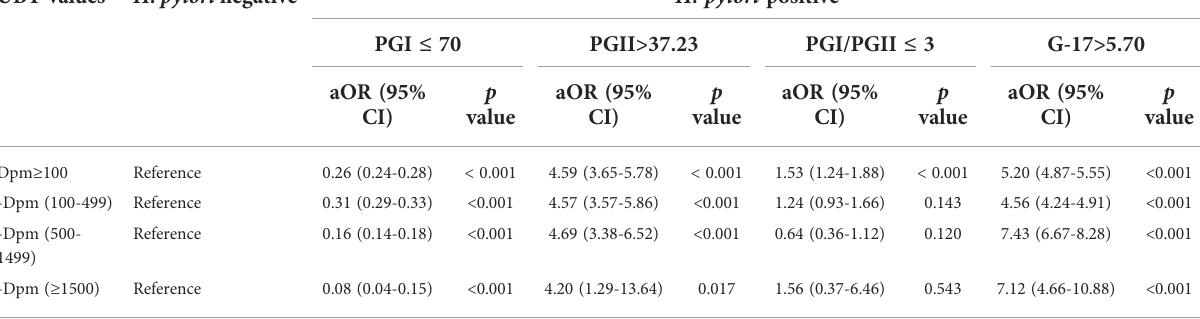
TABLE 2 Adjusted ORs for abnormalities of serum PGs and G-17 in H. pylori -positive subjects with different UBT values. UBT values